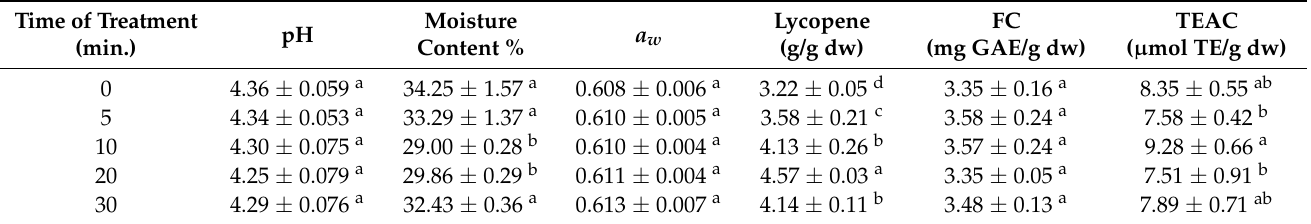
Table 3. Effect of ACP treatment on the physicochemical and antioxidant characteristics of sundried tomatoes. Treatments were carried out at ambient temperatures of 26 ± 1 ◦